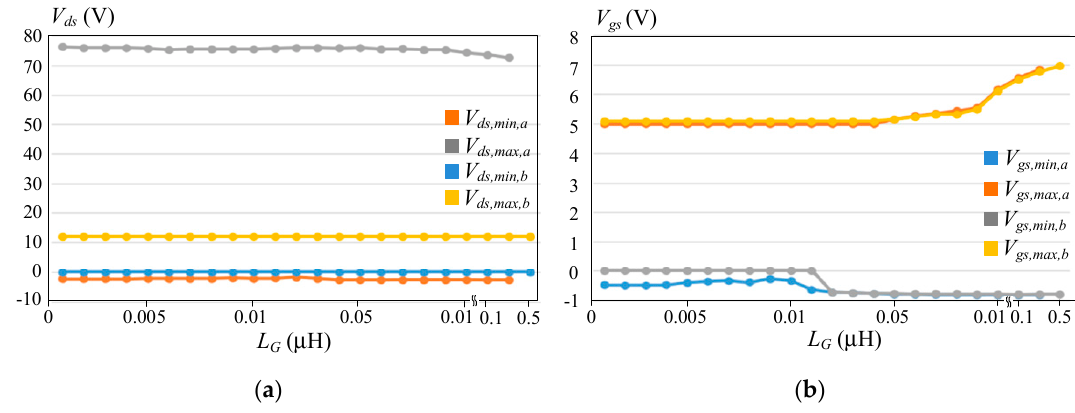
Figure 5. Changes in V ds and V gs for different L G values. ( a ) Changes in V ds,max and V ds,min for different L G values. ( b ) Changes in V gs,max and V gs,min for different L G values. 3.3. Applying Different L S Values to Measure the Changes of I ds , V ds , and V gs When di/dt and dv/dt Occur The parameter setting of I ds = 2 A, L G = 1 nH, f s = 100 kHz, V gs = 5 V, and L S = 0.001–2.000 µ H was applied. The blue curve ( I ds,min,a ) is used when L D = 0.2 µ H and the orange curve ( I ds,min,b ) is used when L D = 1.0 nH to observe changes of I ds . In Figure 6a, I ds,min,a ranges from − 1.40 A to − 1.84 A, whereas the